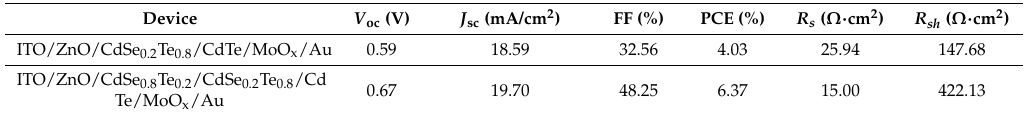
Figure 6. ( a ) J - V characteristics of Device A (ITO/ZnO/CdSe 0.2 Te 0.8 /CdTe/MoO x /Au, black) and Device B (ITO/ZnO/CdSe 0.8 Te 0.2 /CdSe 0.2 Te 0.8 /CdTe/MoO x /Au, red) under light (inset shows the J-V under dark) and ( b ) the corresponding EQE properties of these devices. Table 4. Summarized performances of Device A and Device B (Figure 6).